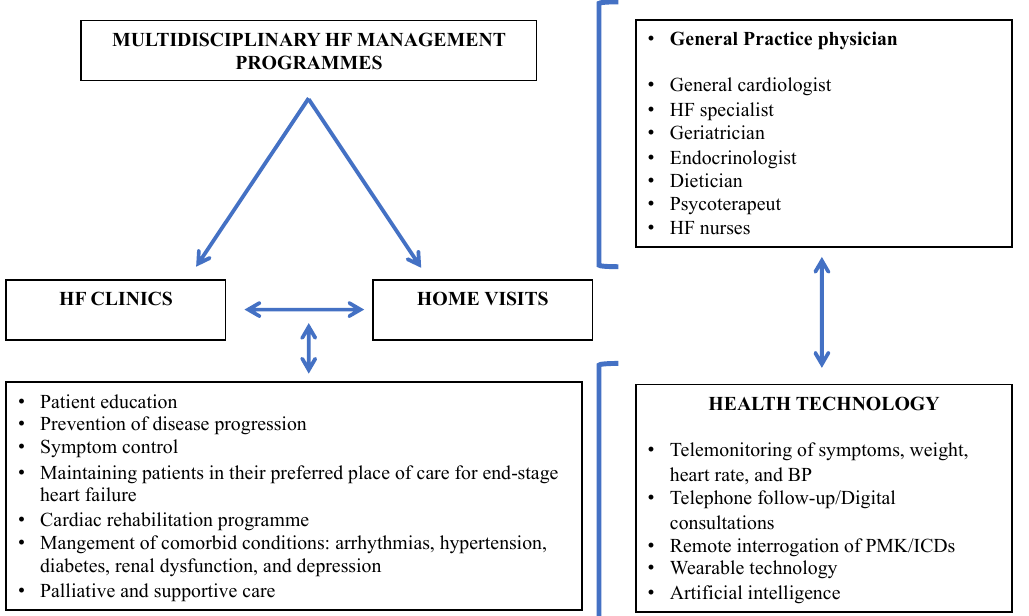
Figure 6. Outpatient management. Abbreviations: BP: blood pressure; HF: heart failure; ICD: implantable cardiac defibrillator; PMK: pacemaker.